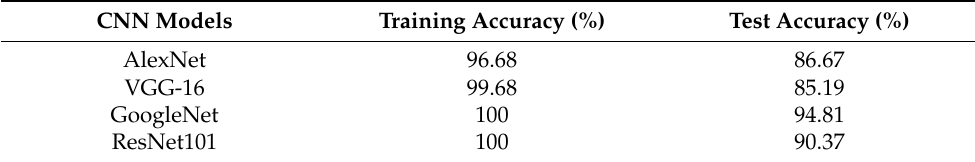
Table 3. Comparison of the prediction accuracy of different CNN models.